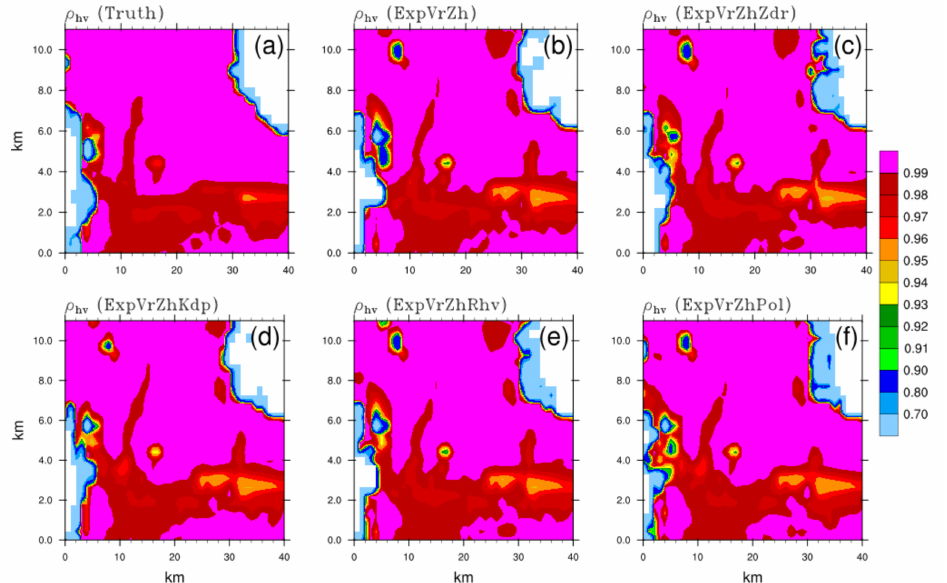
Figure 10. The same as Figure 7, but for the cross-correlation coefficient ρ hv of ( a ) truth, and analysis fields of ( b ) ExpVrZh, ( c ) ExpVrZhZdr, ( d ) ExpVrZhKdp, ( e ) ExpVrZhRhv, and ( f ) ExpVrZhPol,